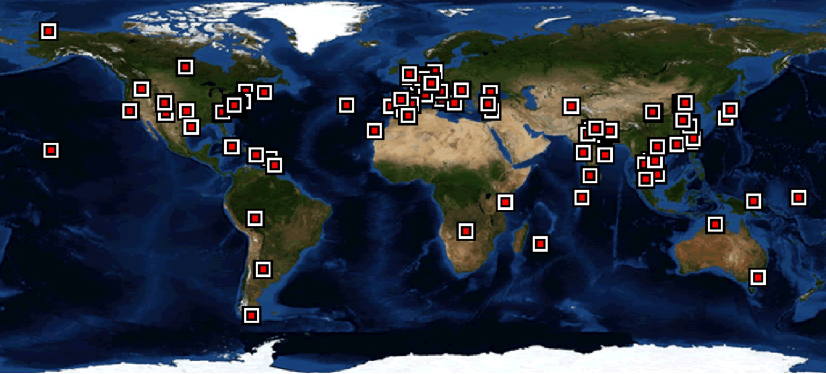
Fig. 2. AERONET cloud-mode site locations (red squares). Among these cloud-mode sites, 13 providing zenith radiance data at 1640nm wavelength are listed in Table 1.